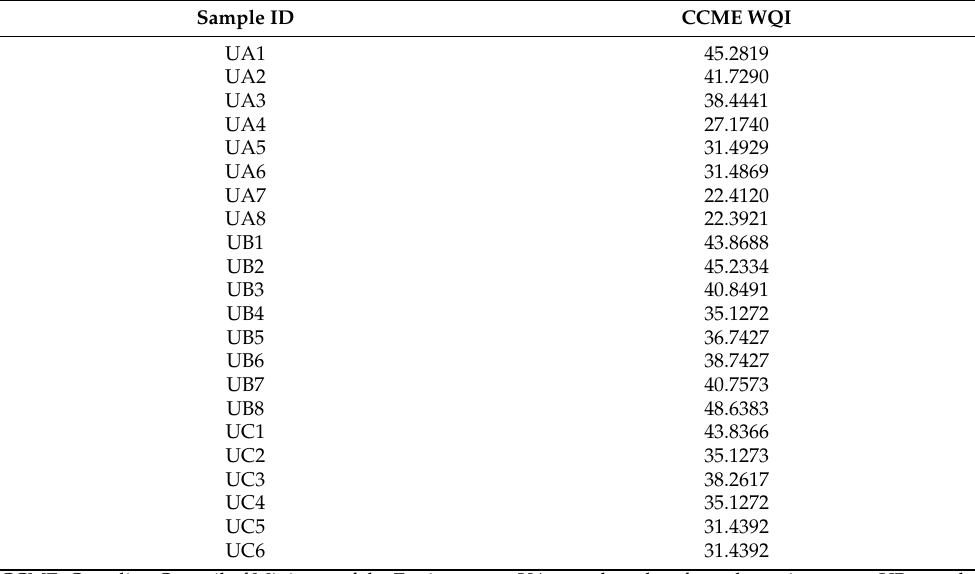
Table 2. CCME WQI Results, Bumbu River